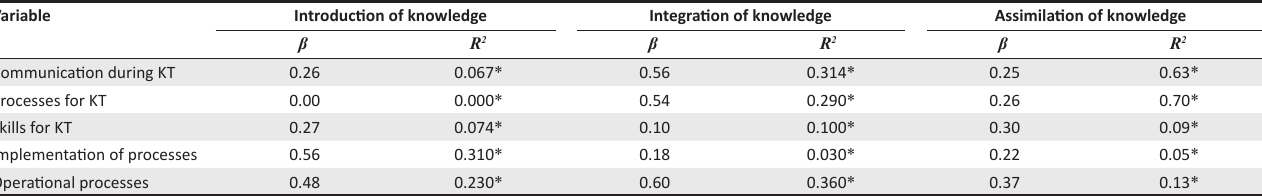
TABLE 5: Linear regression data.